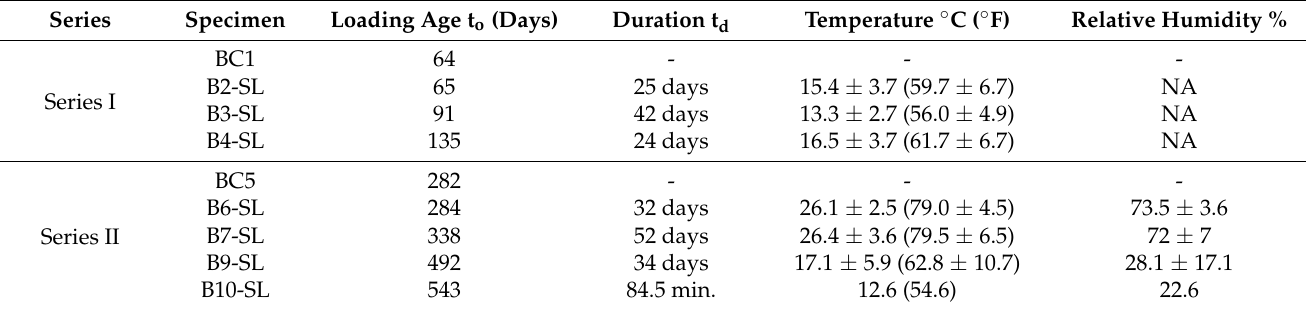
Table 1. Specimen summary including temperature and relative humidity during testing.